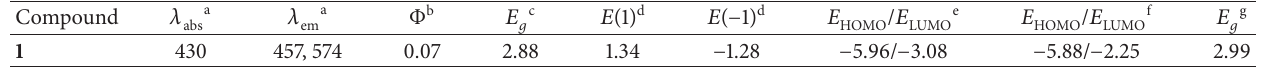
Table 2: Calculated and experimental parameters for 1 .